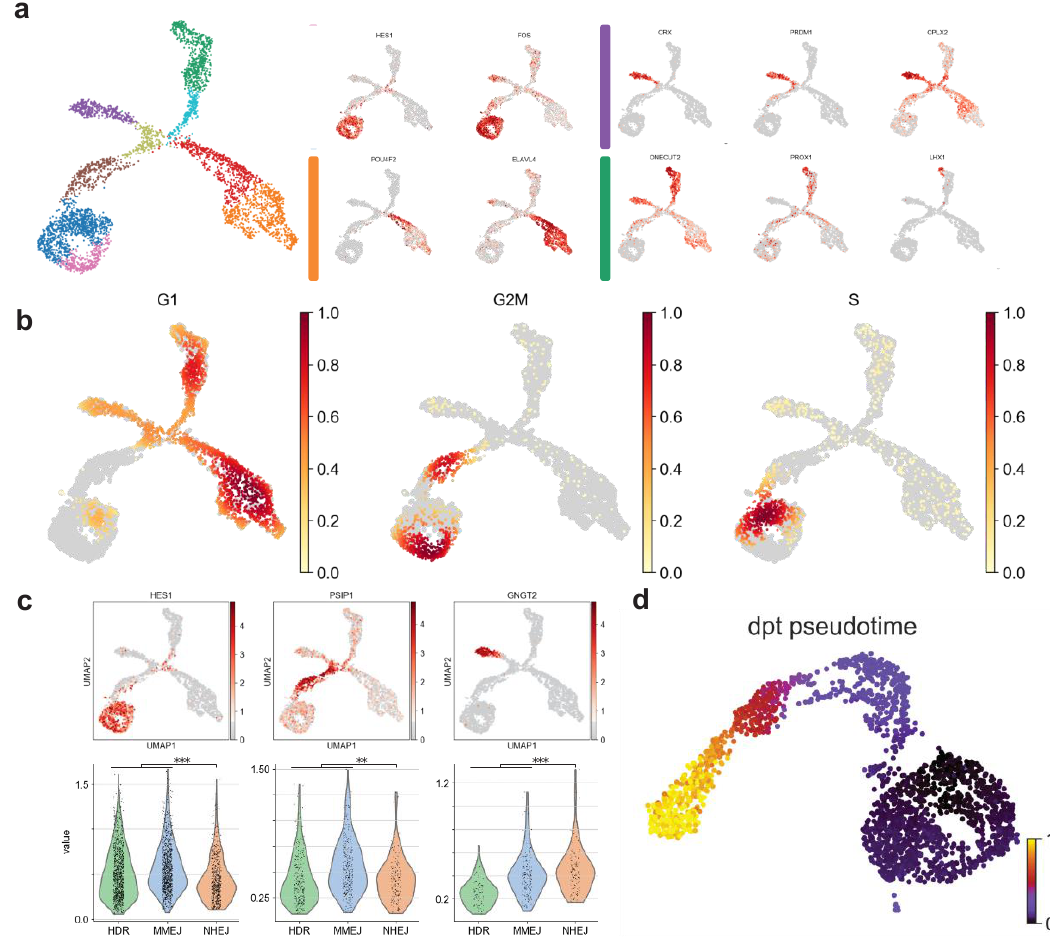
Figure A1. E15 mouse retina scRNA-seq. ( a ) E15 mouse retinal cells in two-dimensional UMAP showing canonical retinal markers expressed in relation to the annotated clusters. ( b ) 2D visualization of E15 retinal cells, showing cell-cycle scores across the cells. Retinal progenitors form a circle in the UMAP embedding, resembling the cell-cycle before cell-type commitment. ( c ) DSB repair pathway scores compared ( t -test) across progenitor, neuroblast, and photoreceptor precursor cell-types. ( d ) Photoreceptor developmental trajectory of E15 in two-dimensional UMAP colored by diffusion pseudotime (dpt pseudotime) order.